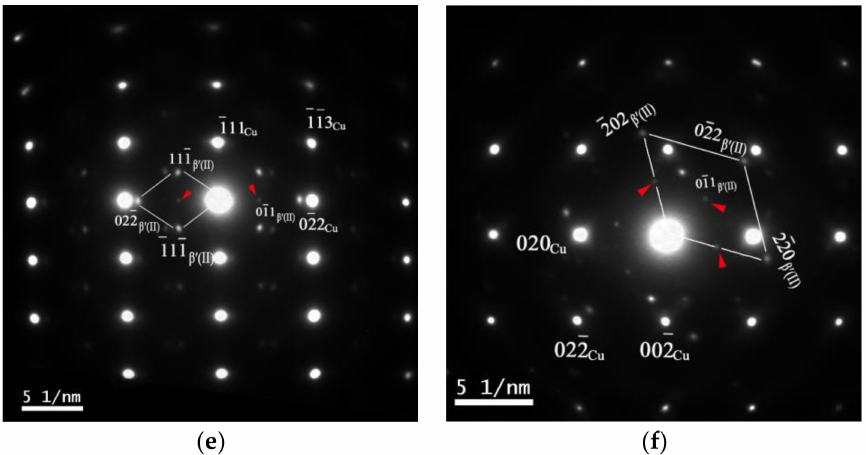
Figure 5. BF micrographs and selected area electron diffraction (SAED) patterns of the studied alloy aged at 723 K for various durations: ( a ) 30 min and ( b ) 240 min. SAED patterns were taken from samples aged for 30 min, from beams along the zone axis of: ( c ) [110] Cu and (d) [111] Cu ; and aged for 240 min, from beams along the zone axis of: (e) [211] Cu and (f) [100] Cu .